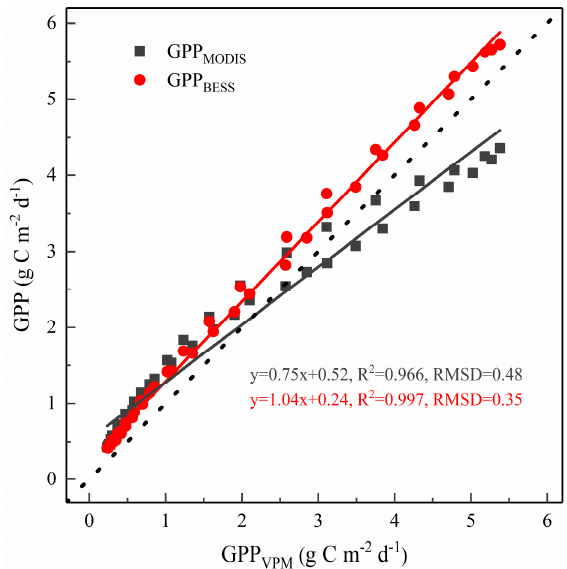
Figure 5. Gray rectangles and red dots show the intercomparison between the MODIS and BESS GPP products against the VPM GPP estimates at an 8-day period, respectively. The dashed line represents the 1:1 line, and the red and gray lines represent the linear fits.